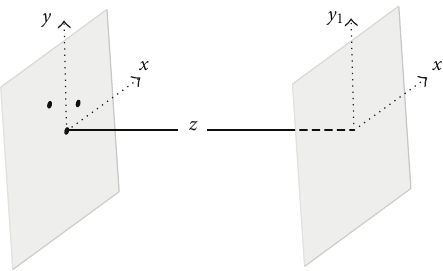
Figure 9: Schematic of the three pinholes arrangement for vortex lattice generation.